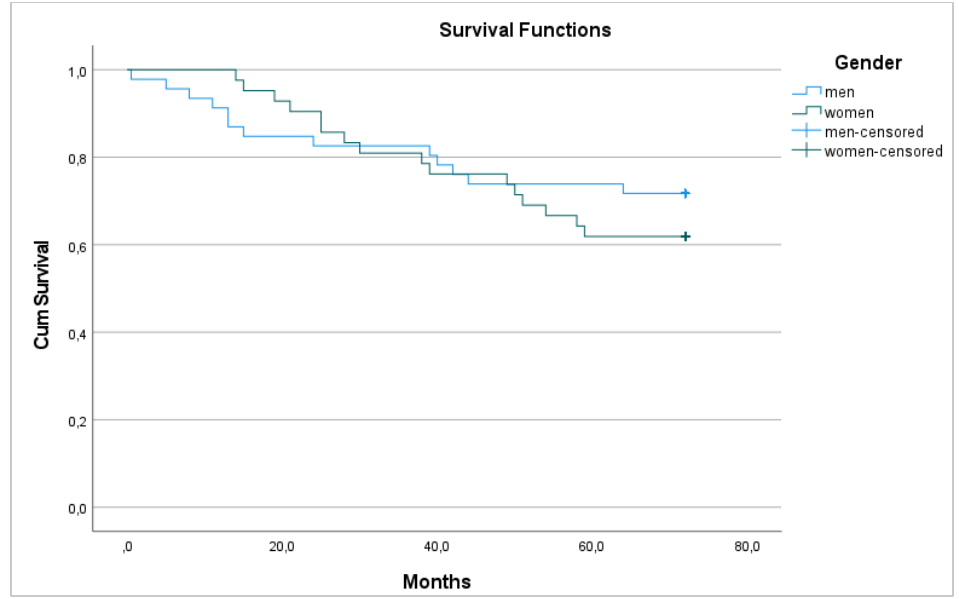
Figure 2. 6-year overall survival between men and women. Most patients had stage III cancer — 37 (42%). Patients with stage IV cancer did not survive after 6 years, although all patients with a tumor in situ survived ( p < 0.001) (Figure 3).